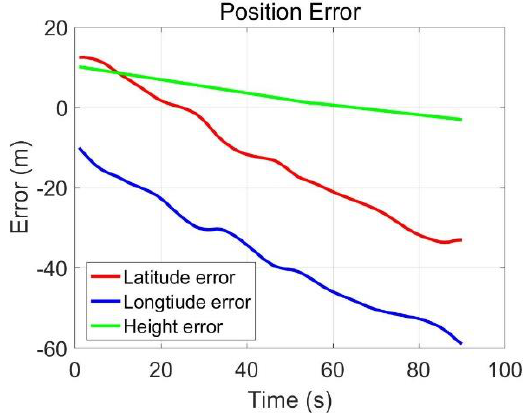
Figure 7. Field testing trajectory.